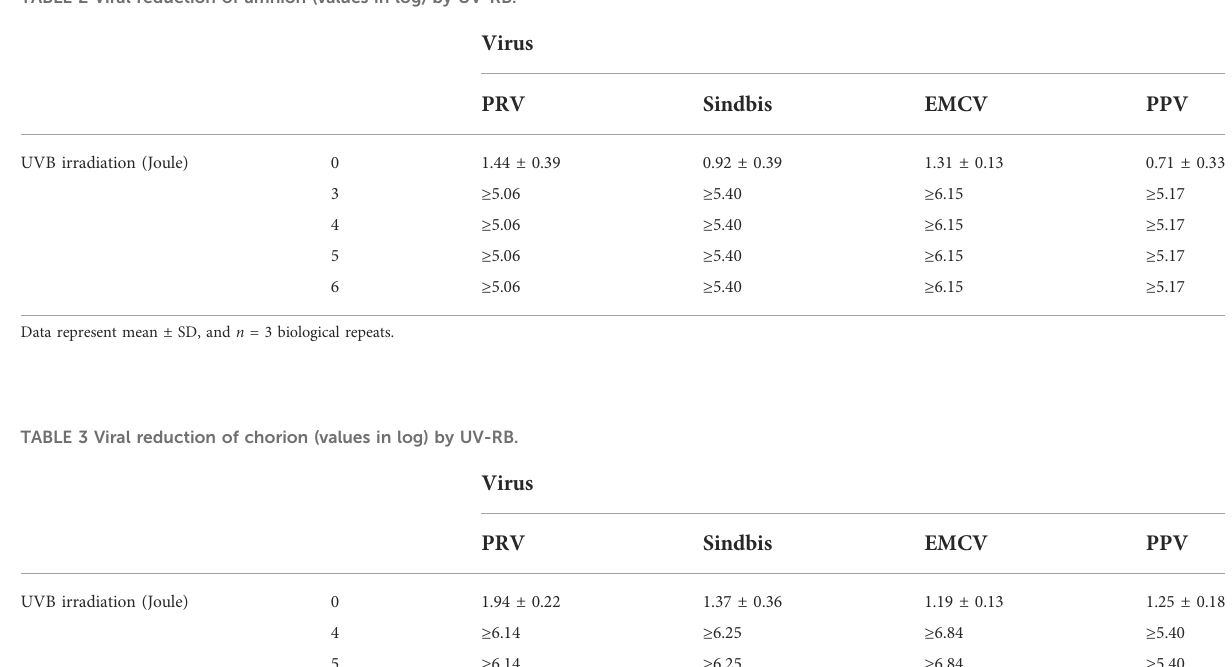
TABLE 2 Viral reduction of amnion (values in log) by UV-RB.